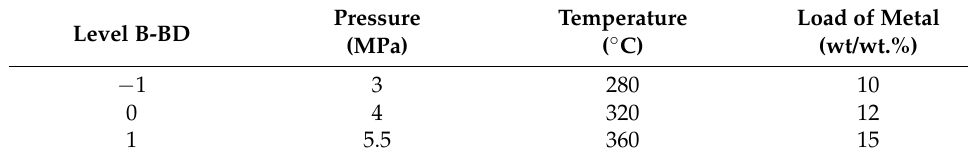
Table 6. Coded levels of experiments involved in the Box–Behnken design. Pressure Temperature Load of Metal Level B-BD (MPa) ( ◦ C) (wt/wt.%) −